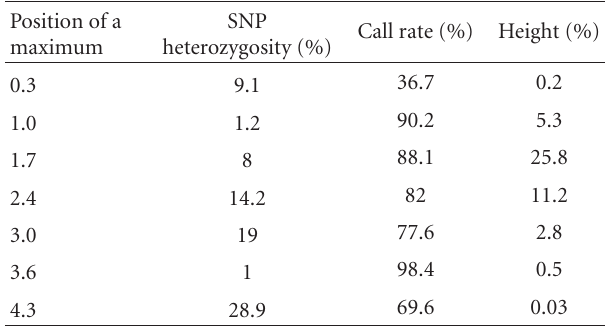
Table 2: Heterozygosity and call rate of SNPs within seven maxima of signal intensity for ovarian cancer cell line OVCAR8 (see Figure